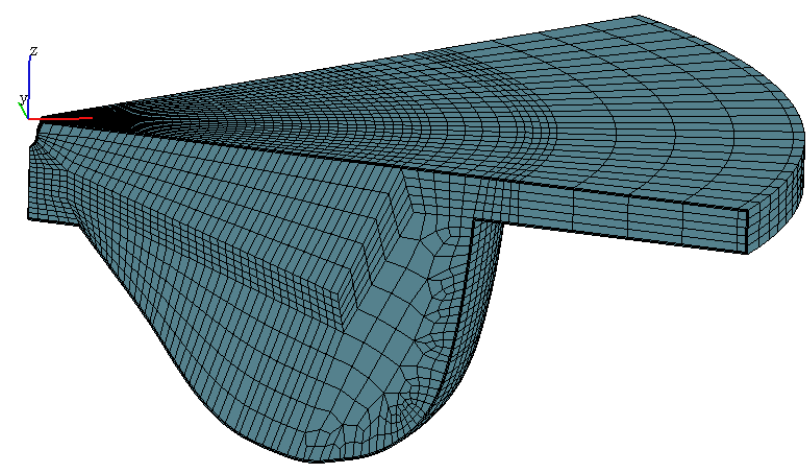
Figure 2. 3D mesh model of engine combustion chamber.